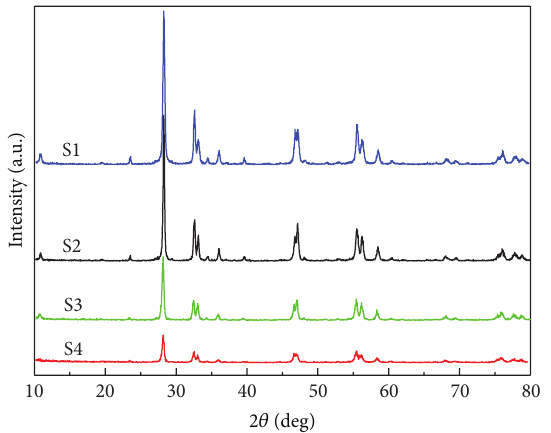
Figure 1: XRD patterns of S1–S4